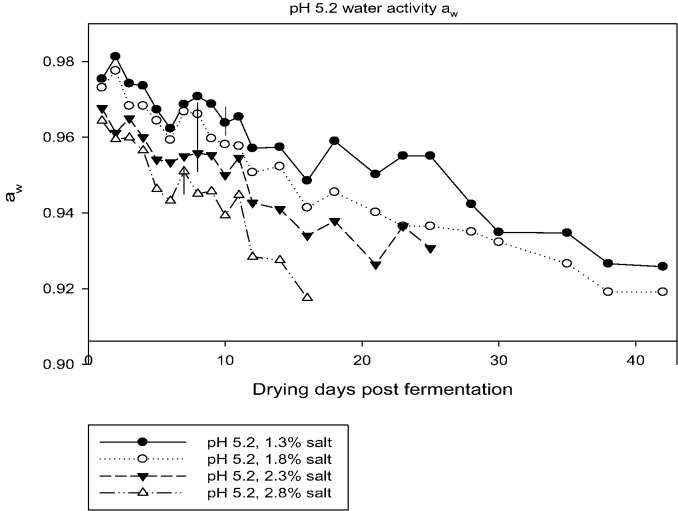
Time in days until sausage chubs reached endpoint aw of 0.92.Vertical line indicates last day upon which infective larvae were found in mice.